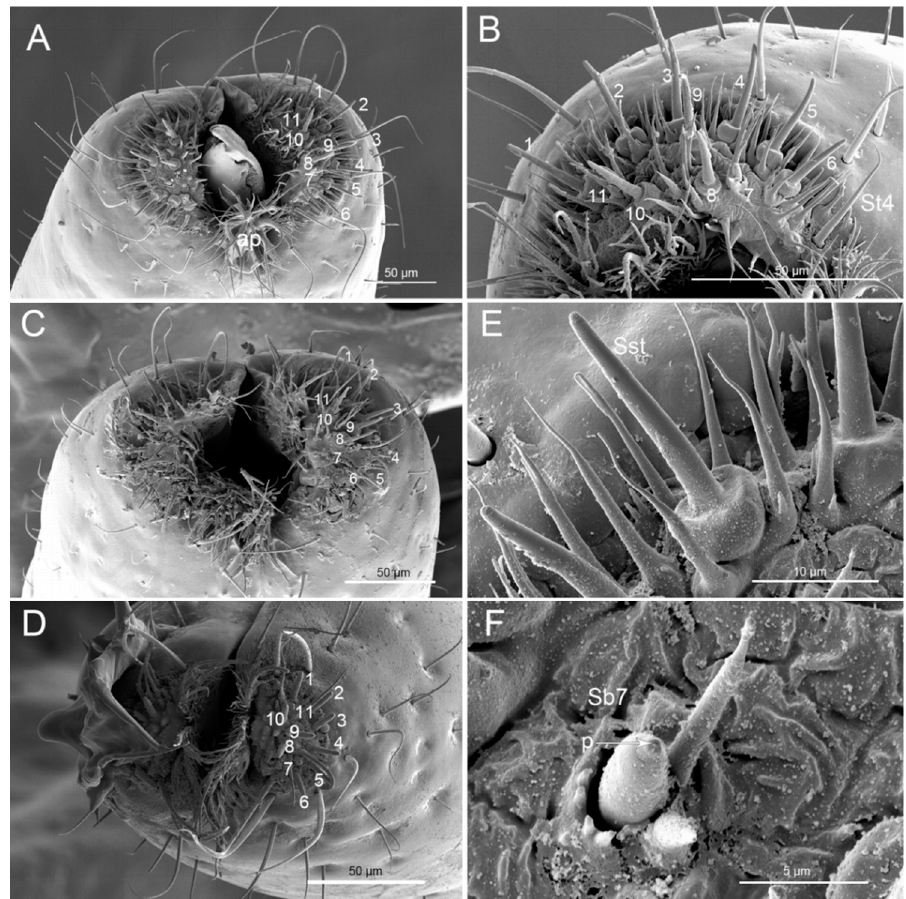
Figure 9. SEM images of the tip of the labium. ( A ) Vertical view of the tip of Picromerus bidens ; ( B ) Right side of the tip of Picromerus bidens showing sensilla basiconica VII (Sb7) (nos. 7 and 11), sensilla styloconica (nos. 1–6, 8–10) and sensilla trichodea IV (St4); ( C ) Vertical view of the tip of Picromerus lewisi ; ( D ) Vertical view of the tip of Cazira bhoutanica ; ( E ) Sensillum styloconicum (Sst); ( F ) Sensillum basiconicum (Sb7); p, pore.